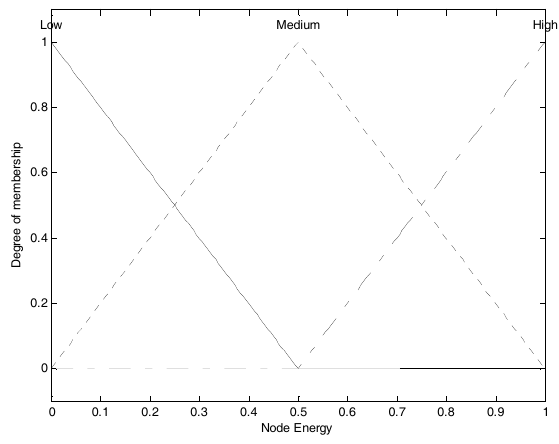
Figure 2. Nodes energy membership function.